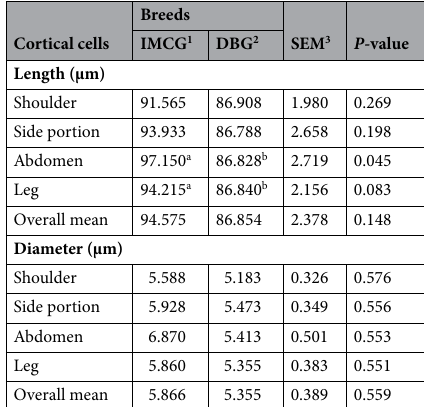
Table 4. Cortical cell length and diameter in IMCG 1 and DBG 2 parents goat breeds (mean ± SEM). 1 IMCG Mongolia Cashmere goat, 2 DBG Dazu black goat, 3 SEM the standard error of the mean. a–c Means with different superscript in the same row are differ ( P <